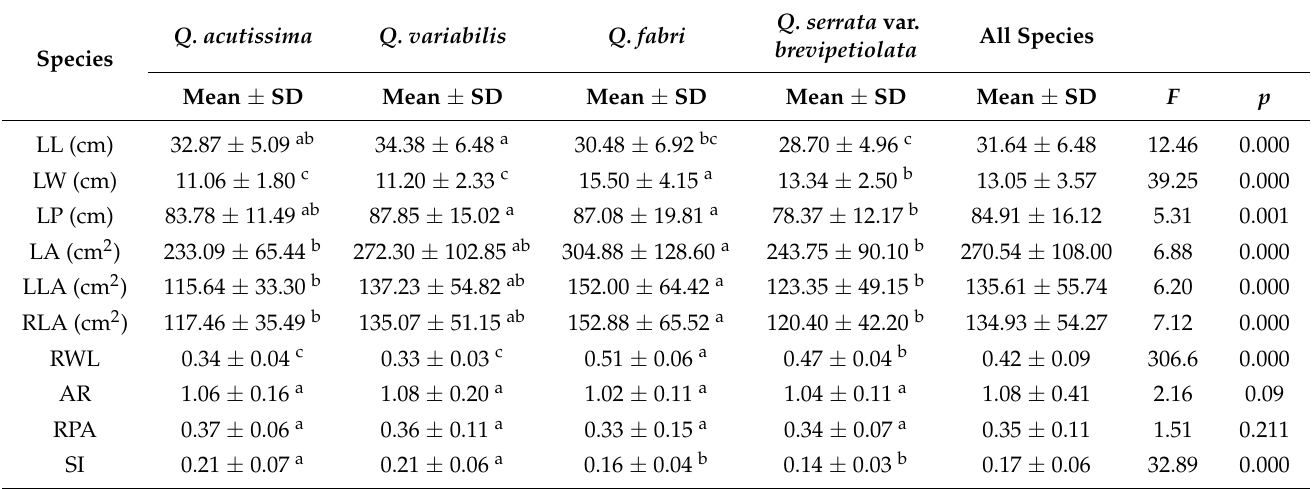
Table 3. ANOVA e summary of leaf phenotypic indexes among the four-oak